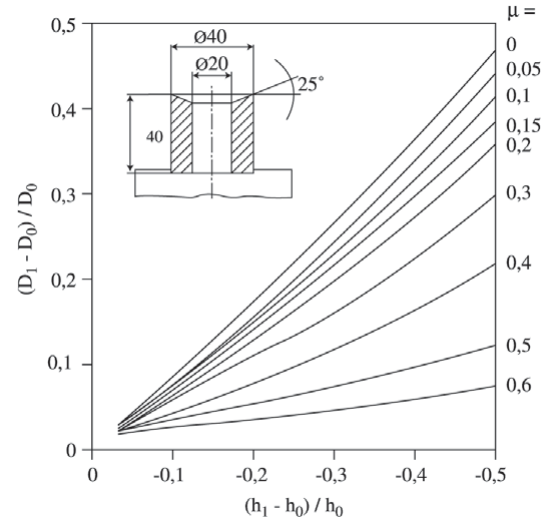
Figura 4. Curvas de calibração anel e tubo cônico 6